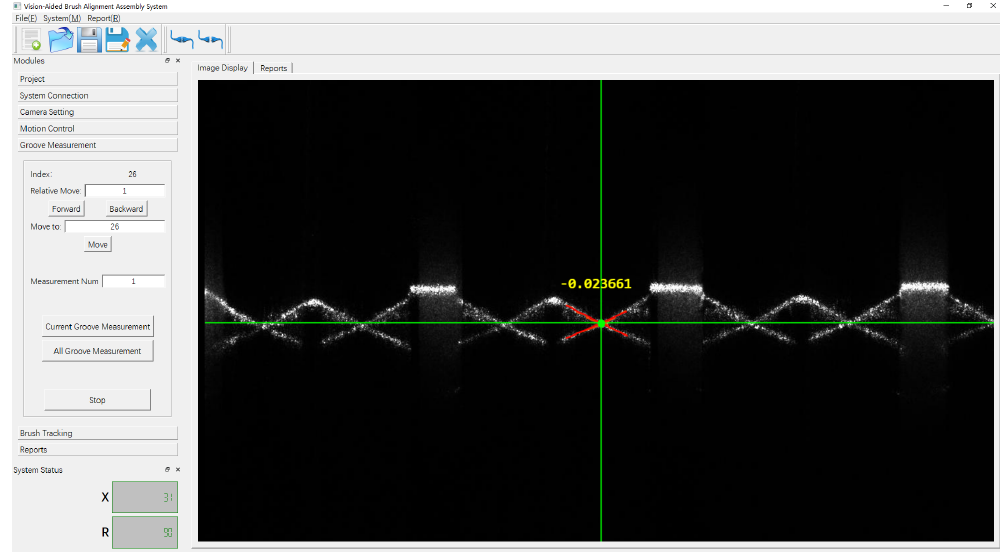
Figure 11. Software developed for vision-aided brush alignment assembly system.